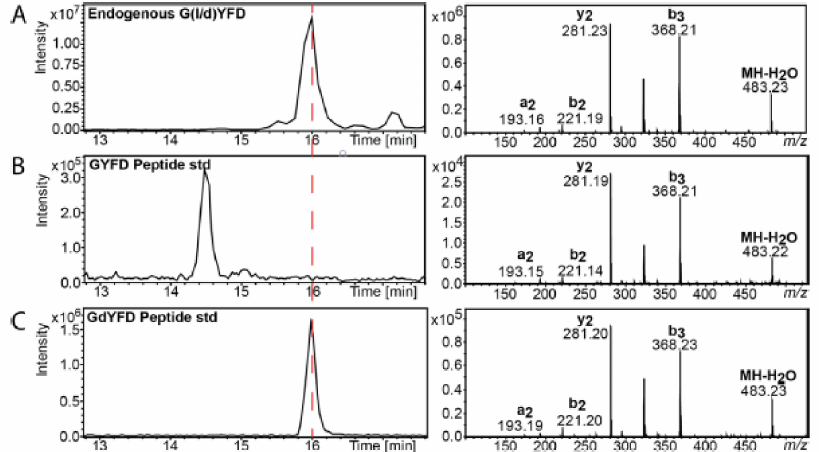
Figure 5. LC − MS/MS characterization of GdYFD, which is confirmed by comparing to the retention time of standards. ( A ) Left, LC − MS (base peak chromatogram) trace of endogenous GYFD after 48 h of APM digestion, with a retention time of 15.9 min. Right, the MS/MS fragmentation with fragment assignments is shown. ( B ) Left, an LC − MS trace of the all- L -amino acid synthetic GYFD, with a retention time of 14.5 min. Right, the MS/MS fragmentation with fragment assignments. ( C ) Left, an LC − MS trace of the synthetic DAACP GdYFD, with a retention time of 15.9 min. Right, MS/MS fragmentation with fragment assignments is shown. The matching retention time of the synthetic GdYFD standard with the endogenous GYFD demonstrates that the sequence for the endogenous peptide is in fact GdYFD. Reproduced with permission from